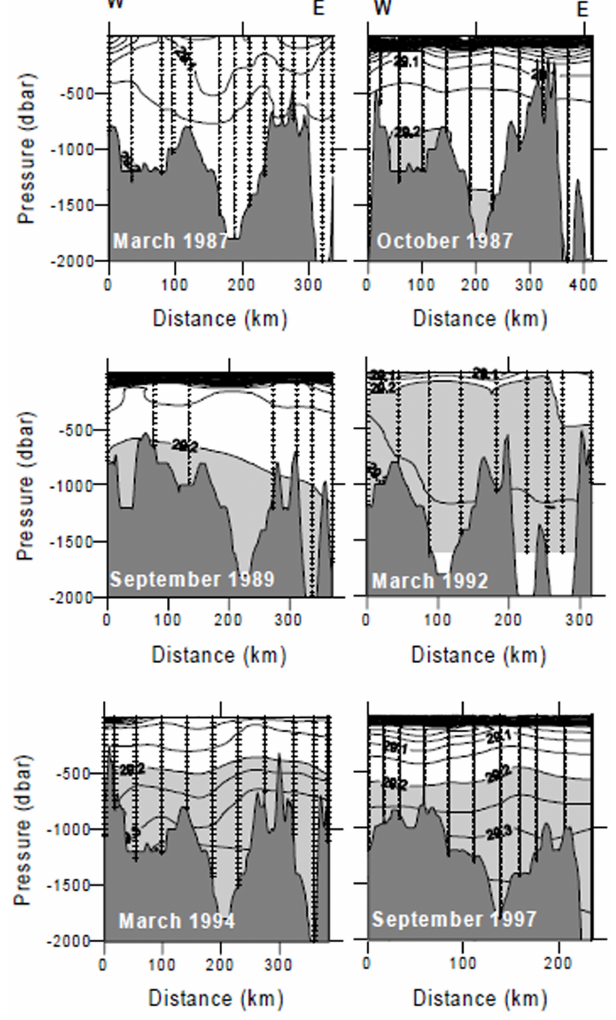
Fig. 6. West–east σ θ cross-sections in the Cretan Sea showing the evolution of the 29.2kgm − 3 surface during the decade